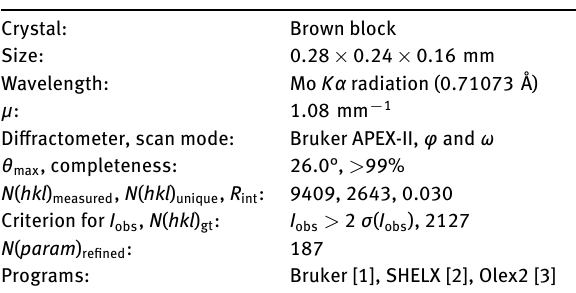
Table 1: Data collection and handling.